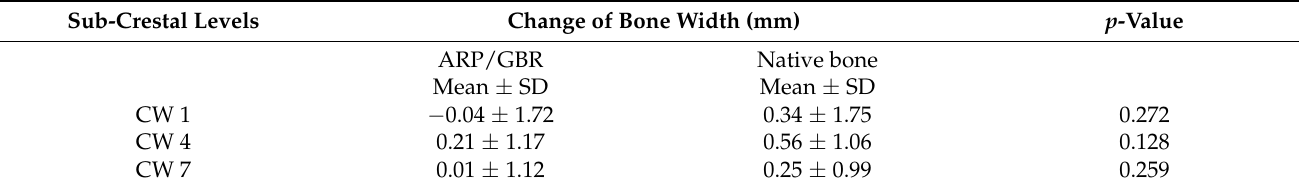
Table 4. The difference in the change of bone width around implants at three levels were found between implantation at native bones and ridge preservation/augmentation